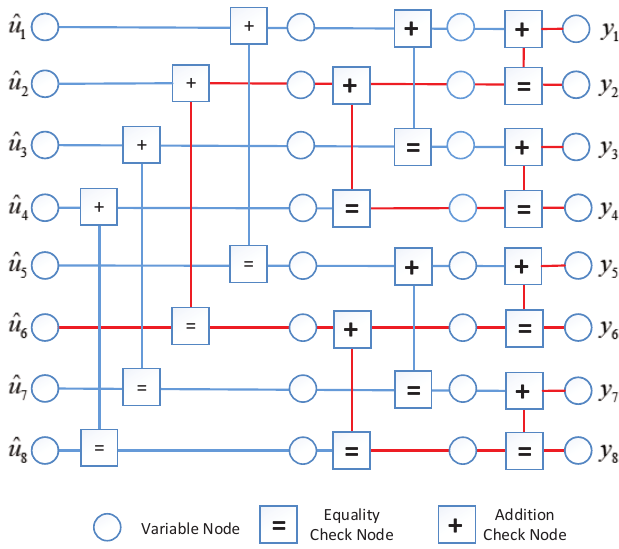
Figure 1. The processing of construction of polar